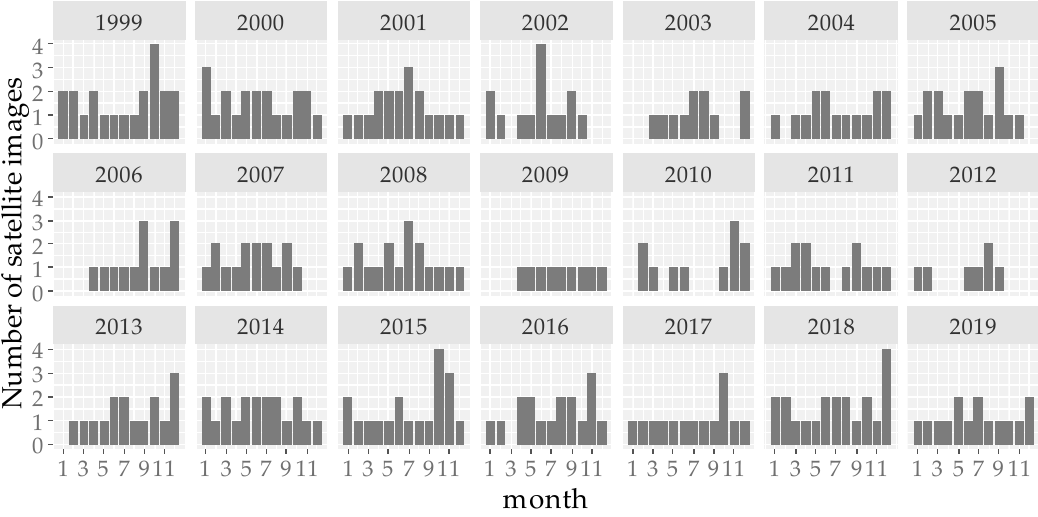
Figure 2. Temporal distribution of Landsat Collection 1 Surface Reflectance (SR) imagery. More images were used (when available) where clouds obstructed data collection or where SLC off-data error in Landsat 7 was detected over study